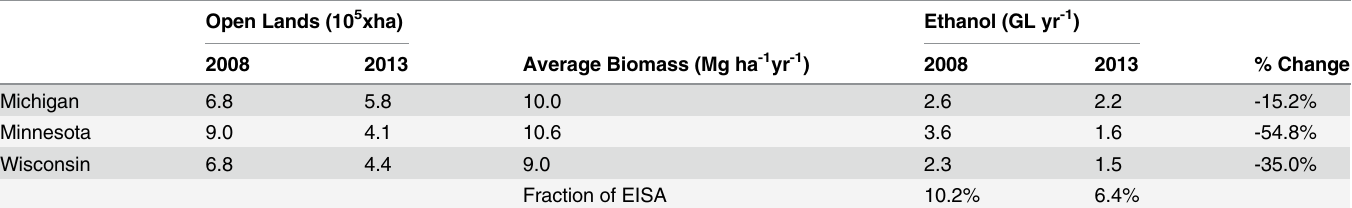
Table 2. Environmental Quality Integrated Climate (EPIC) model simulated biomass and ethanol production potential on open lands in the Lake States in 2008 and 2013 [23]. Results are also presented as a fraction of the Energy Independency and Security (EISA) act of 2007 mandate for ethanol pro- duction targets for 2022.